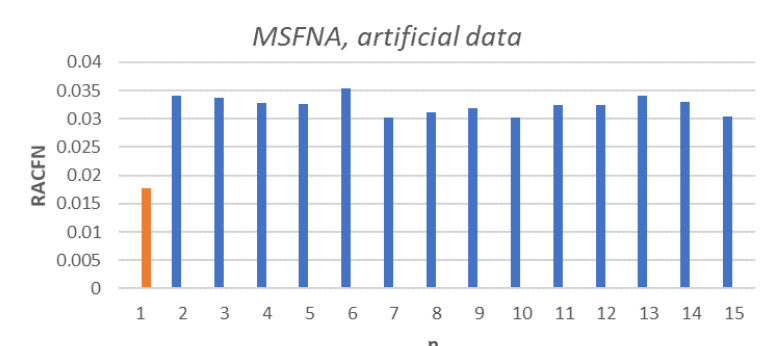
Figure 5. MSFNA on artificial data, the orange column corresponds with the input vector designed by BFSA, the rest of input combinations (blue) have a significantly higher number of FN, the results are consistent with the